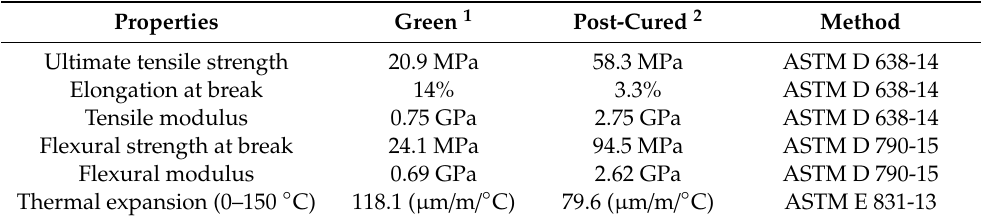
Table 1. Properties of the high-temperature resin.